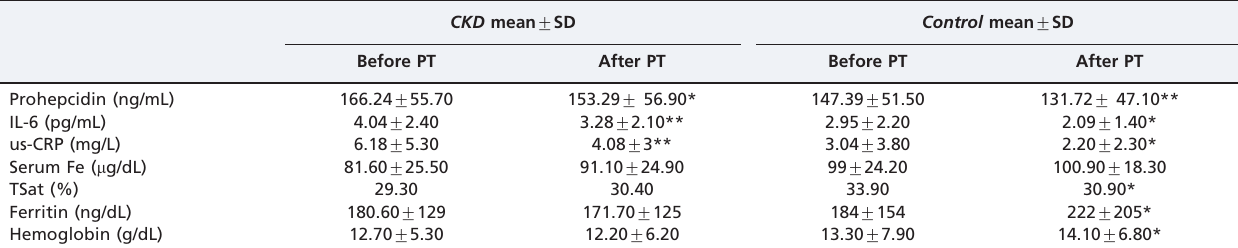
Table 3 - Parameters of inflammatory and biochemical markers before and 3 months after periodontal treatment.